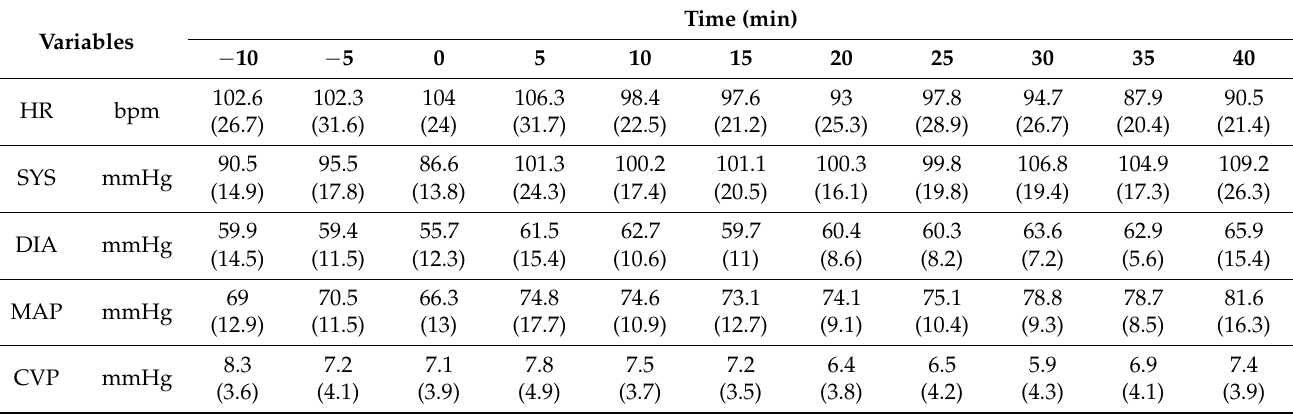
Table 4. Hemodynamic variables in non-hypotensive dogs ( n = 12) after protamine infusion.